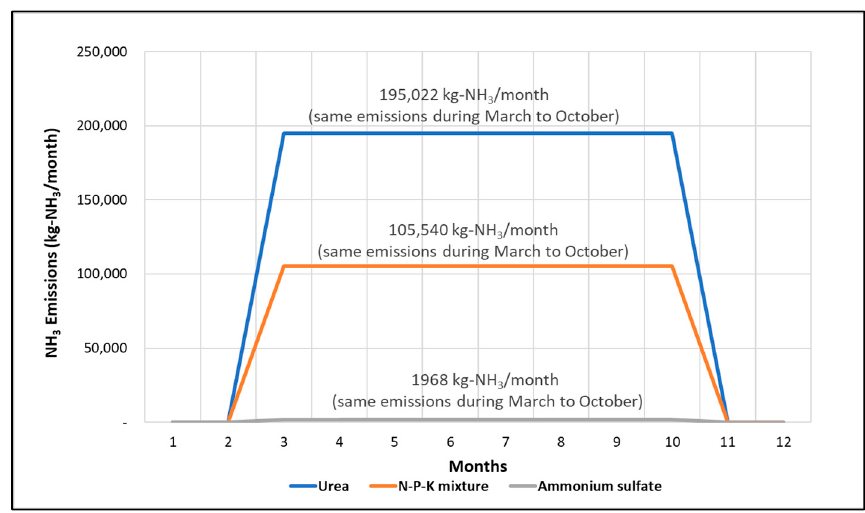
Figure 4. NH3 emissions by fertilizer in Jeolla-do (2017) with Method I.